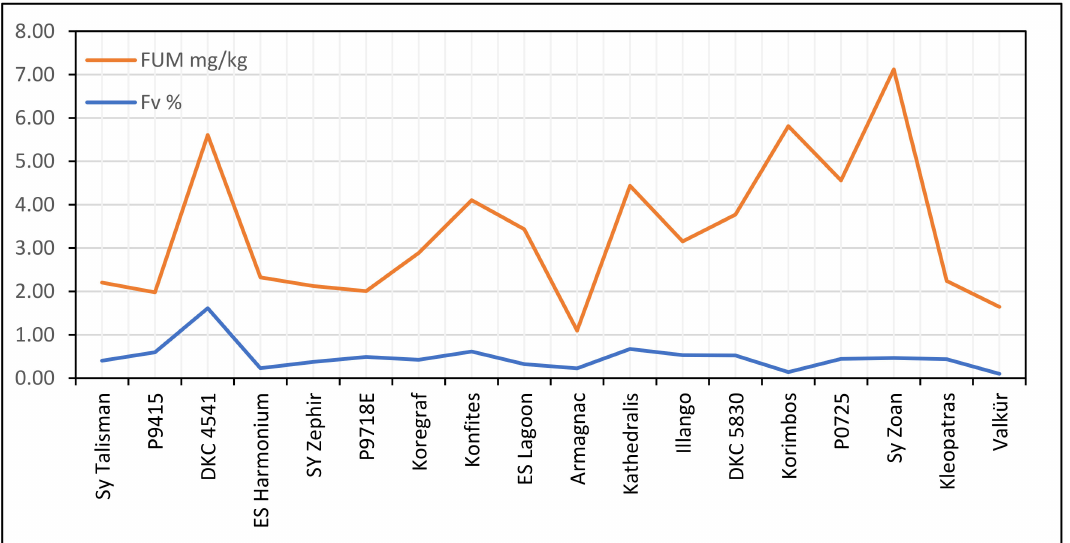
Figure 5. F. verticillioides ear rot and fumonisin B 1 +B 2 production in the commercial hybrids following artificial inoculation (Szeged, 2019–2020). The variance for Fumonisin B 1 +B 2 can be found for each genotype in Table